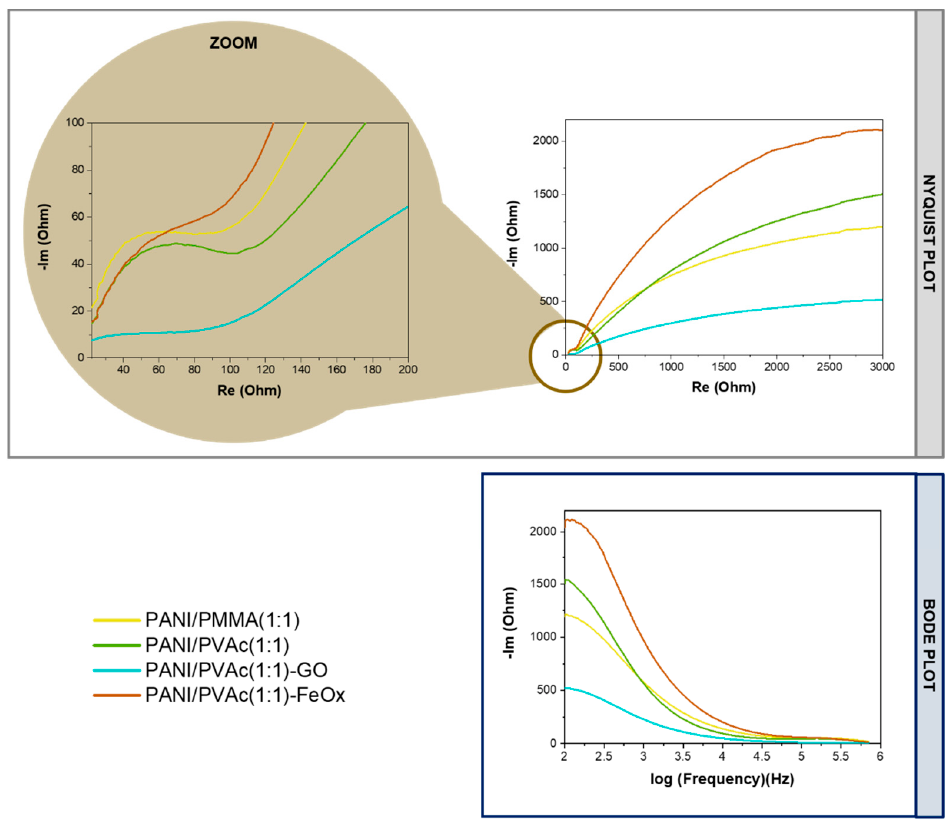
Figure 6. Impedance spectra of electrospun blended mats: Nyquist and Bode plot. Equivalent circuit (Figure S6) was used to model the EIS experimental data: R e is referred to the bulk electrolyte resistance, C c and R c are the polymeric mats layer capacitance and resistance respectively, Cdl is the double-layer capacitance, R ct is the charge-transfer and σ is the coefficient of Warburg [49]. Respective values are reported in Table 2. The R e value for PANI/PMMA (1:1) was higher than that of PANI/PVAc (1:1), proving that a higher R e value was associated with greater compactness of mats [49]. In our samples,